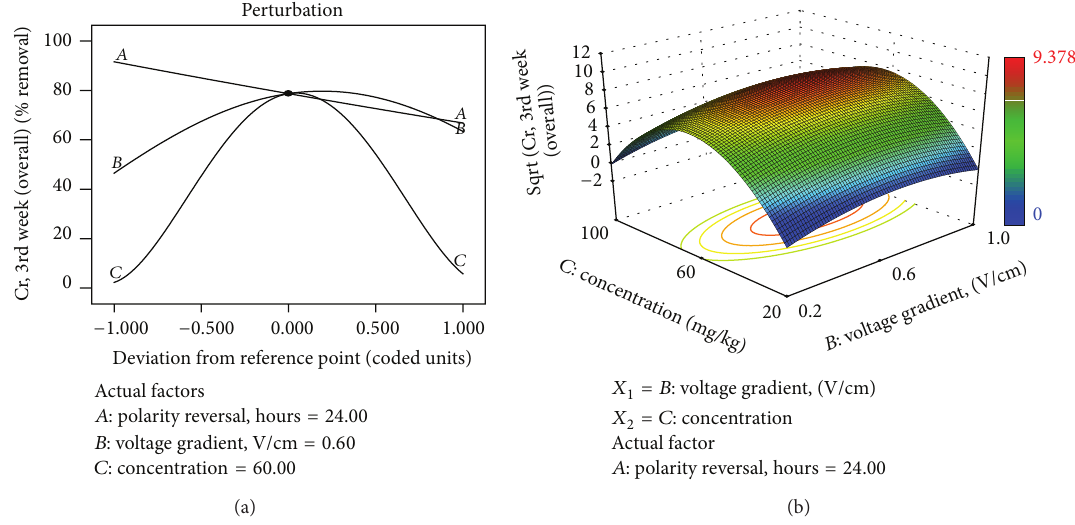
Figure 14: (a) Perturbation plot showing the relative significance of factors on trivalent Cr remedial efficiency. (b) 3D response surface and contour plots showing the influence of initial contaminant concentration on trivalent Cr remedial efficiency.